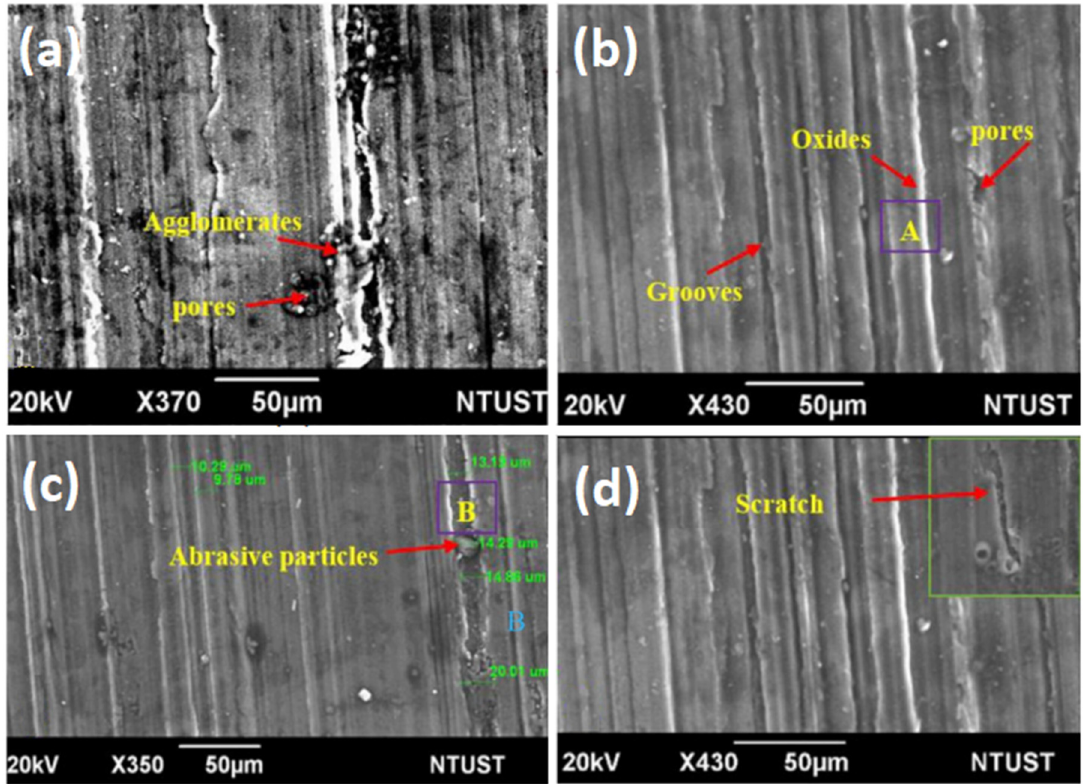
Figure 9. Scanning electron microscope (SEM) images of worn surfaces of AZ31-CNTs composites including ( a ) 1.0 wt.%, ( b ) 0.5 wt.%, ( c ) 0.1 wt.%, and ( d ) 0 wt.% of CNTs, under dry sliding conditions [35].